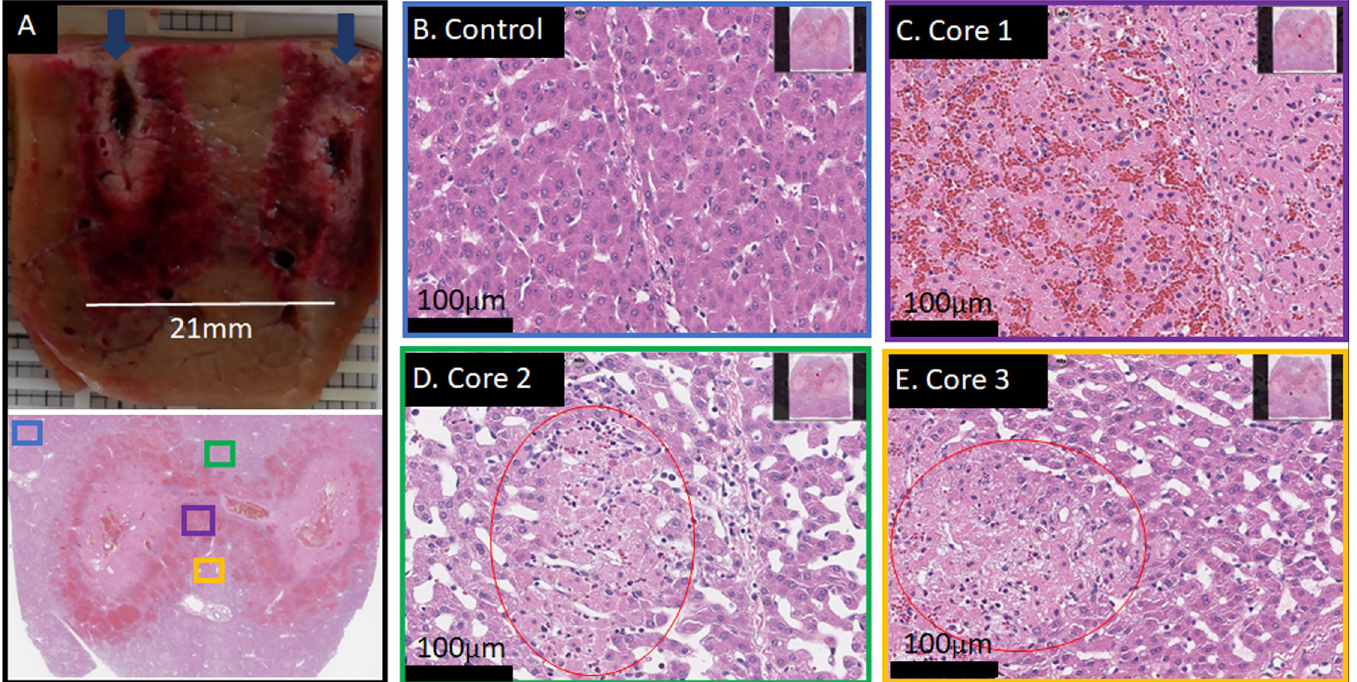
Fig 3. A 4-electrode array ablation with insufficient treatment outcome. Treatment parameters the same as shown in Fig 2. Liver harvest was 22h post treatment. Six waveforms at 1200V (every pair once) were delivered in total. (A) Gross pathological cut between two electrodes of a 4-electrode array ablation. Only within a thin path which connects the two electrodes, complete cell death is found. Dark blue arrows indicate direction of electrode track. (B) Control, H&E stained at 20x magnification. (C) H&E staining of the sample at 20x magnification, illustrating the purple area shown in A. Within the thin path, cells are completely dead. (D and E) H&E stained samples at 20x magnification of the outer areas (green and yellow boxes in A, respectively) at the core of the lesion, which are effected and show “patches” of dead cells (red circles) throughout.